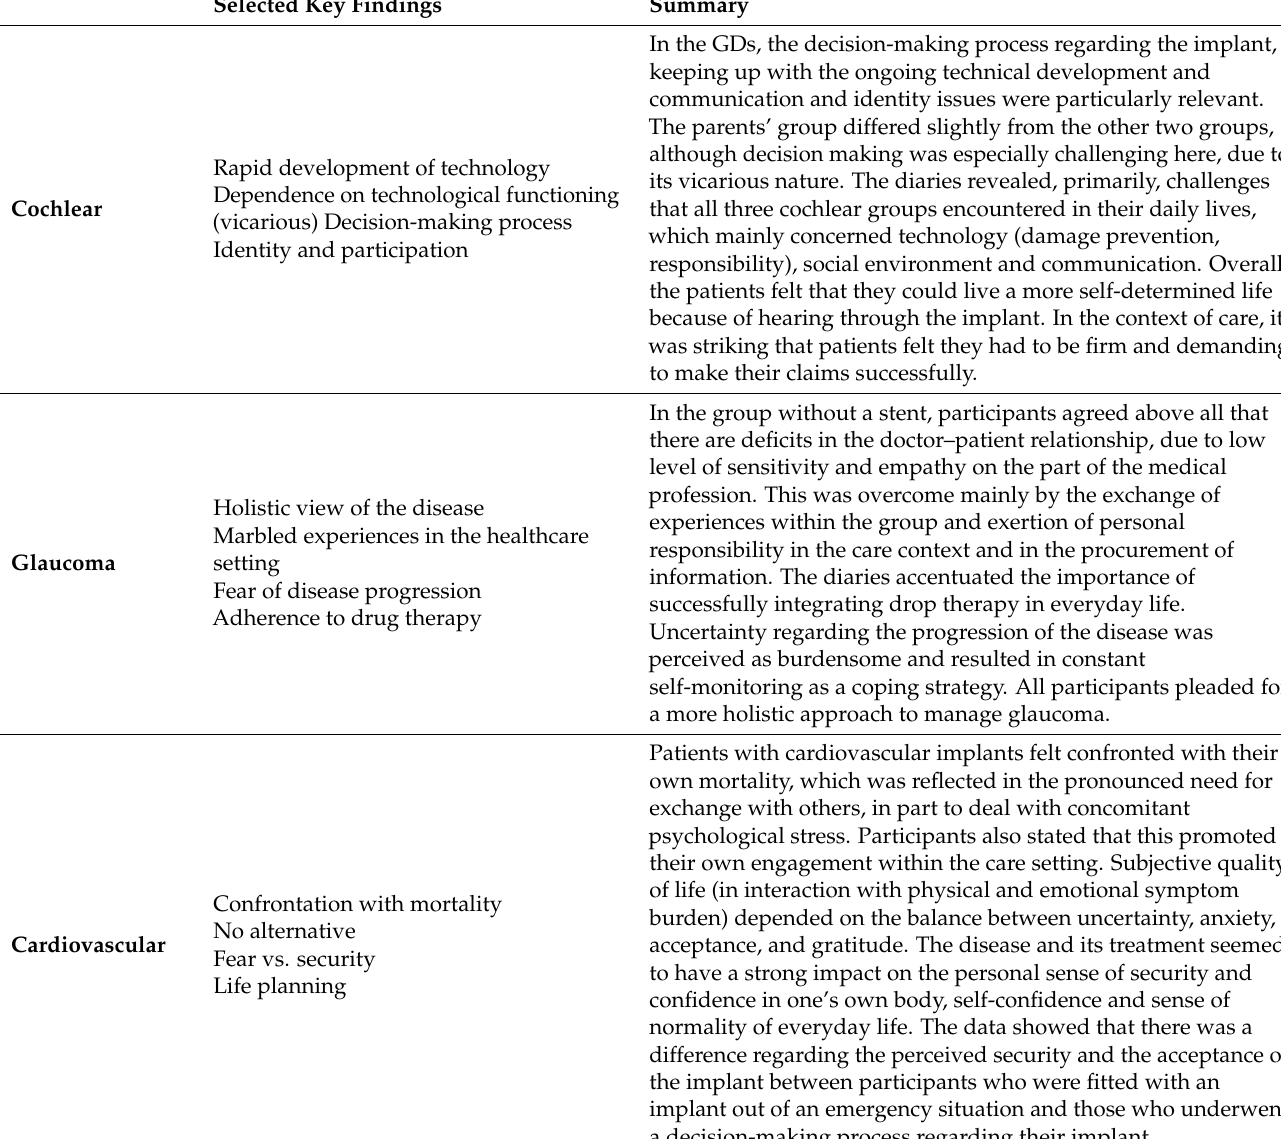
Table 5. Overview of the collective orientation patterns for each implant